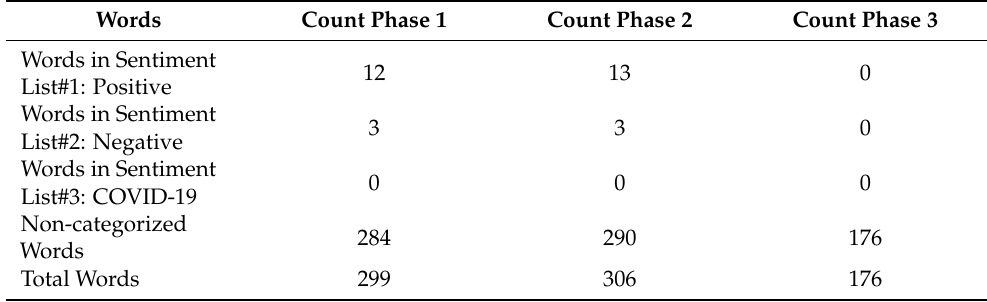
Table 3. Partition by NodeXL of English words used for analysis of the three phases.